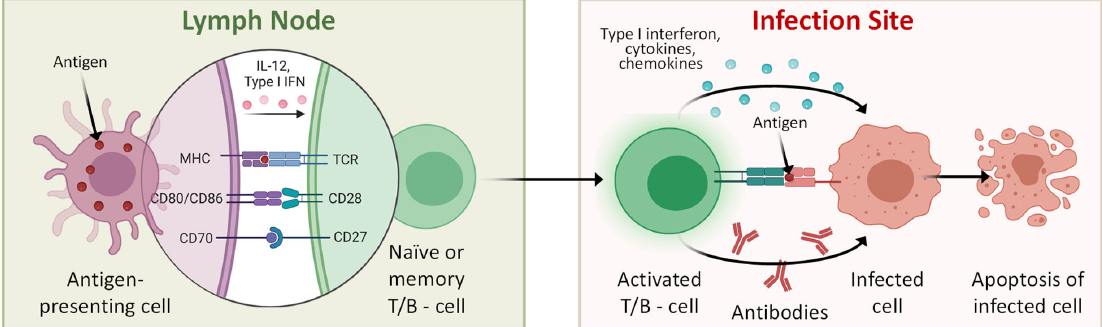
Figure 3. A simplified scheme of adaptive immune response.